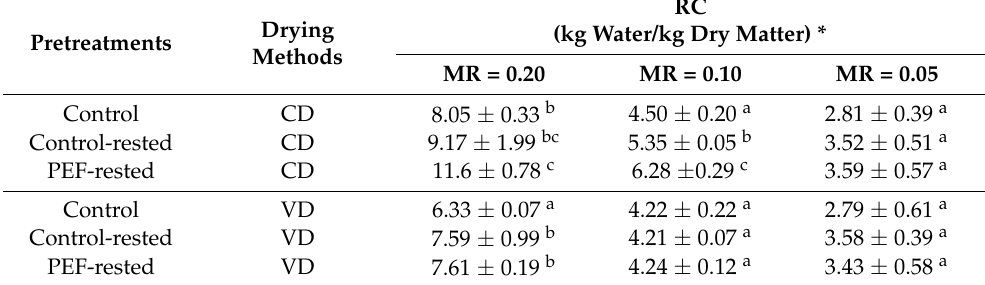
Table 2. The maximum rehydration capacity (RC) obtained after 18 h rehydration of Thai basil leaf samples subjected to different pretreatments and dried by convective drying (CD) and vacuum drying (VD) to MR of 0.2, 0.1, and 0.05. Data are shown as average ± standard deviation of the mean for n =